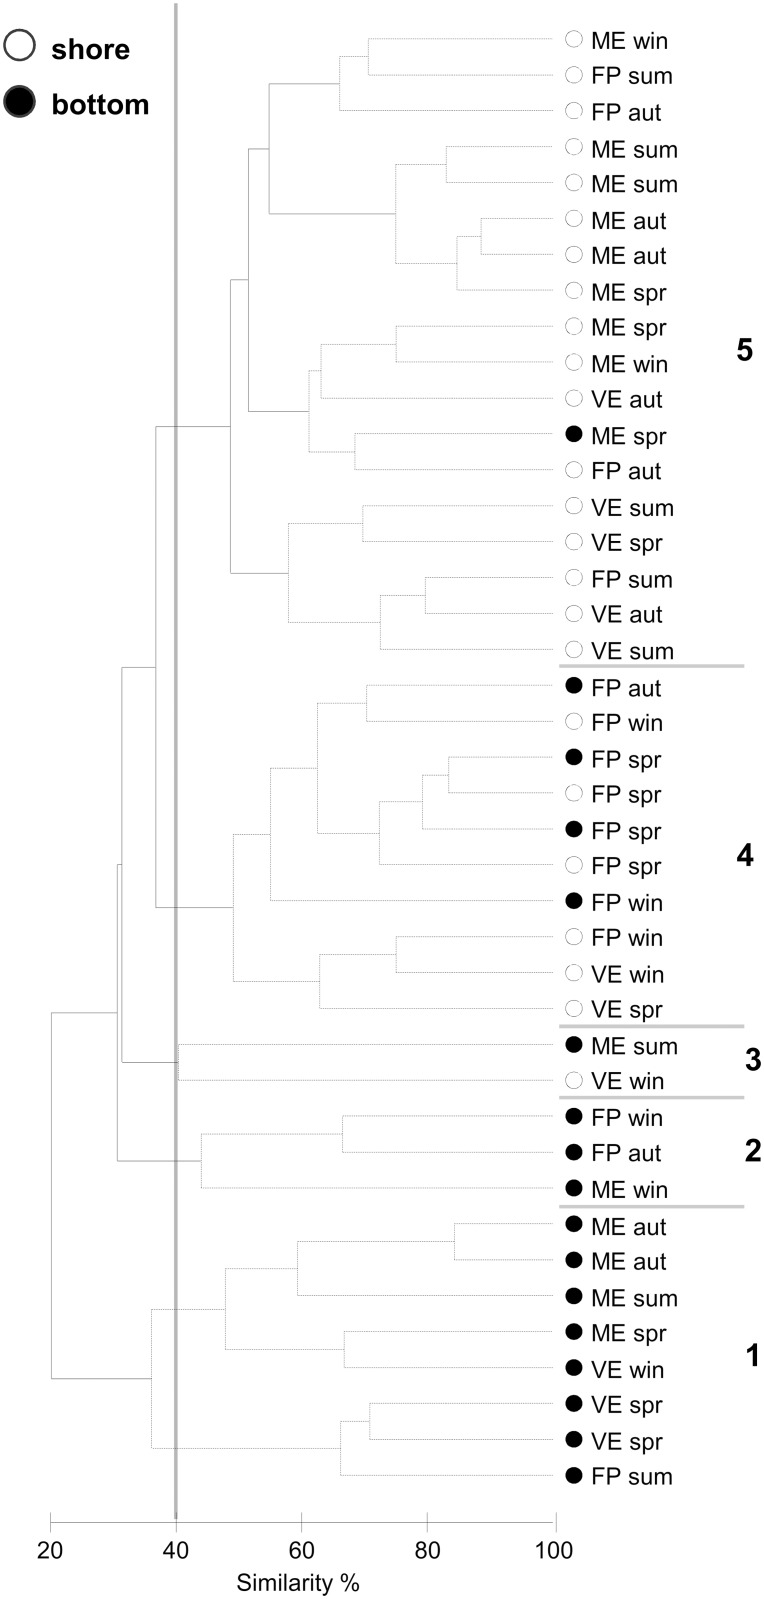
Dendrogram showing the hierarchical clustering (group average linking) of the macrobenthic fauna in the Marinello ponds throughout the sampling seasons.7 samples (VE aut R1, 2; VE win R2; VE sum R1, 2; FP sum R1; ME win R1; all from bottom sites) were excluded from the analysis as they were azoic. The Bray-Curtis similarity index was calculated from the fourth root-transformed abundances of the 11 most dominant taxa. Black branches indicate significant groups according to the SIMPROF test; dotted lines indicate non-significant groups. 5 significant groups (1–5) were identified below the similarity level of 40%. Different colours of the symbols indicate the sampling sites: shore (white circle), bottom (black circle).